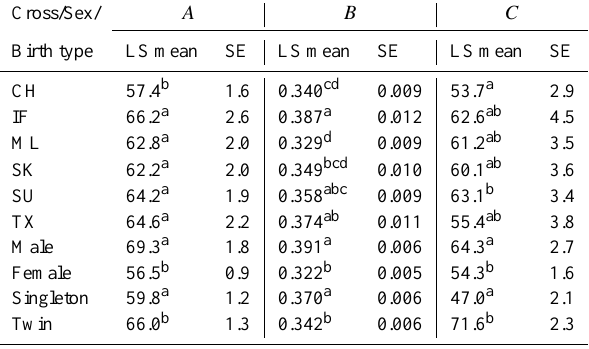
Table 4. Effect of cross, sex and birth type on Gompertz parameters A (estimated mature body weight), B (maximum daily gain) and C (age at maximum daily gain) modelled for fattening lambs.